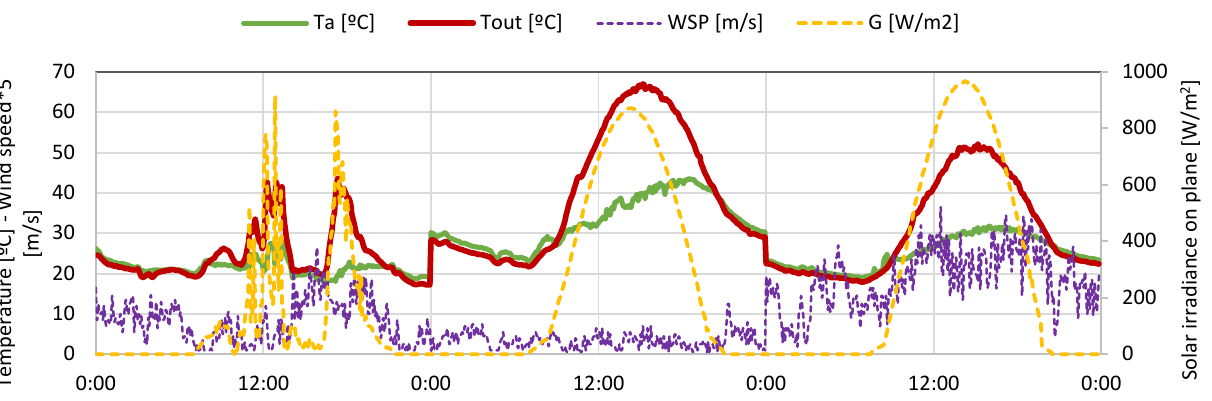
Figure 10. Detail of three days in summer: inlet/outlet temperatures, wind speed, and solar irradiance.